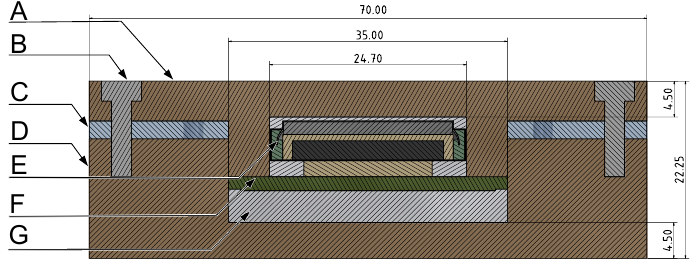
Figure 3. Cross section of the prototype with dimensions. ( A ) upper case, ( B ) steel screw, ( C ) silicone sealing ring, ( D ) lower case, ( E ) coin cell with holder, ( F ) PCB with electronics, ( G ) aerogel-based thermal insulation.